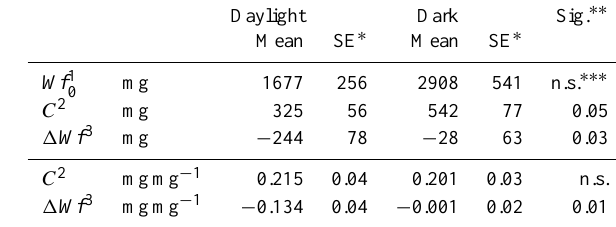
Table 2. Weight and storage of T. recurvata after a one hour fog event at daylight or dark in laboratory conditions.